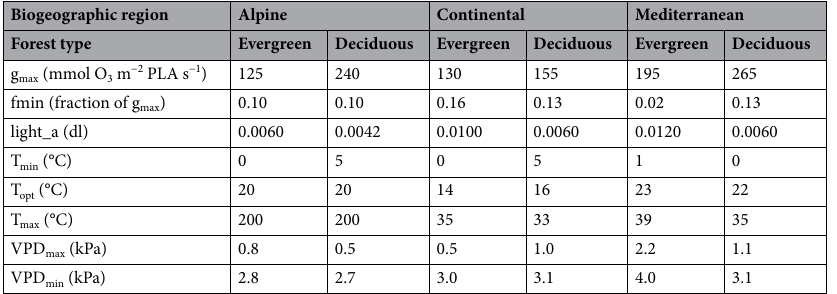
Table 5. Forest-type parameterization of DO3SE model according to 6 . g max , maximum stomatal conductance; f min minimum stomatal conductance; f light_a parameter determining the shape of the hyperbolic relationship of stomatal response to light (dimensionless); T max , T opt and T min are maximum, optimal and minimum temperature for calculating the function f temp that expresses the variation of g max with temperature; VPD min and VPD max are the vapor pressure deficit for attaining minimum and full stomatal aperture calculating the function f VPD that expresses the variation of g max with vapor pressure deficit. The parameters for the soil water content ( f SWC ) and phenological functions ( f phen ) are obtained by the WRF model and vary with the latitude.